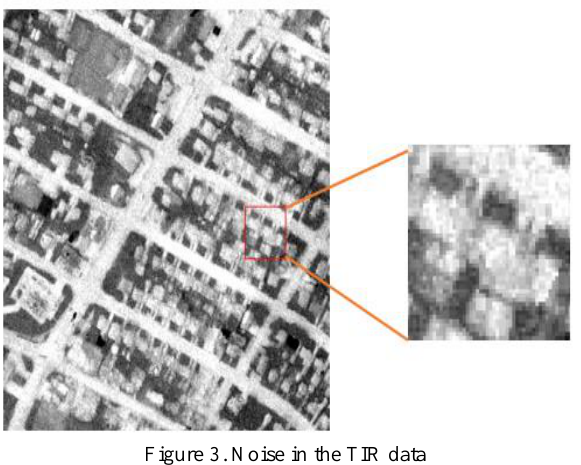
Figure 3. Noise in the TIR